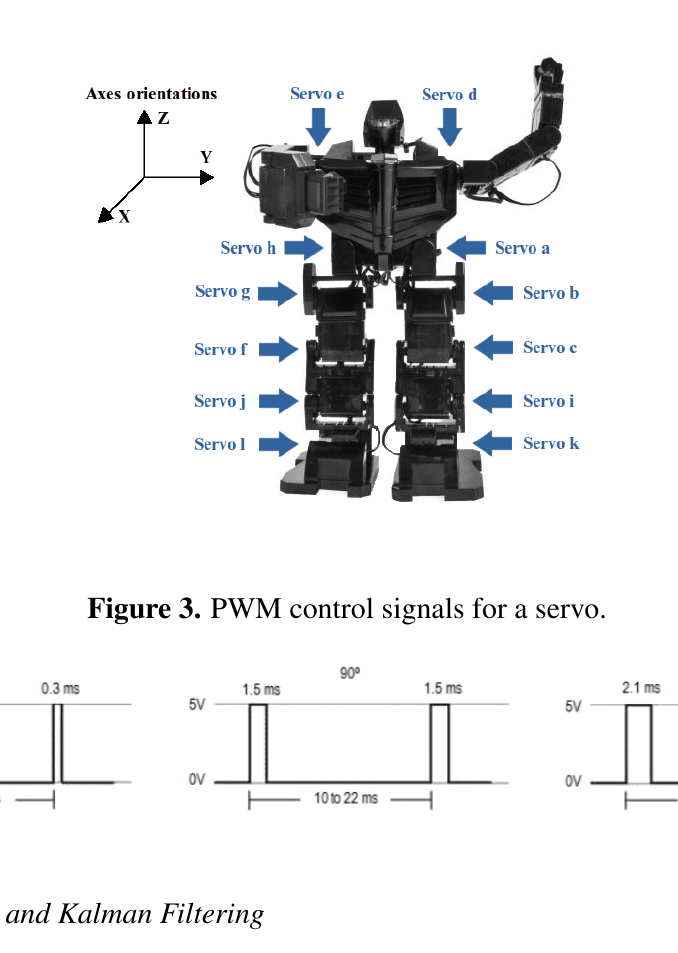
Figure 2. Location of robot servo motors and reference axes orientation.